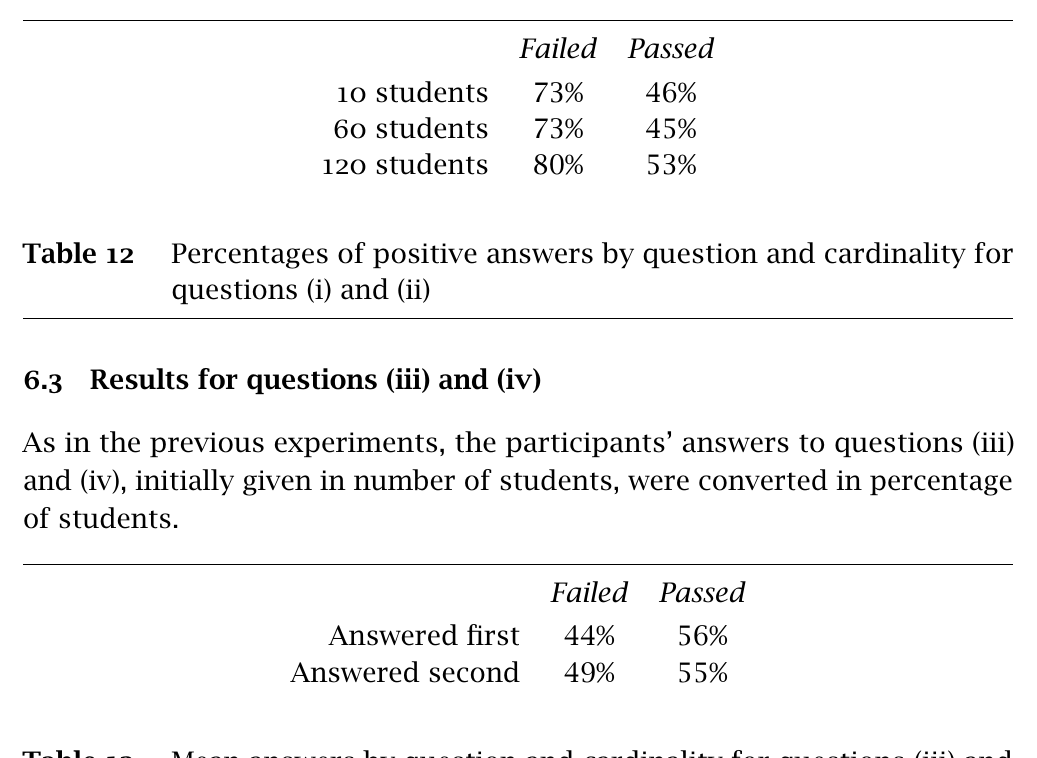
Mean answers by question and cardinality for questions (iii) and